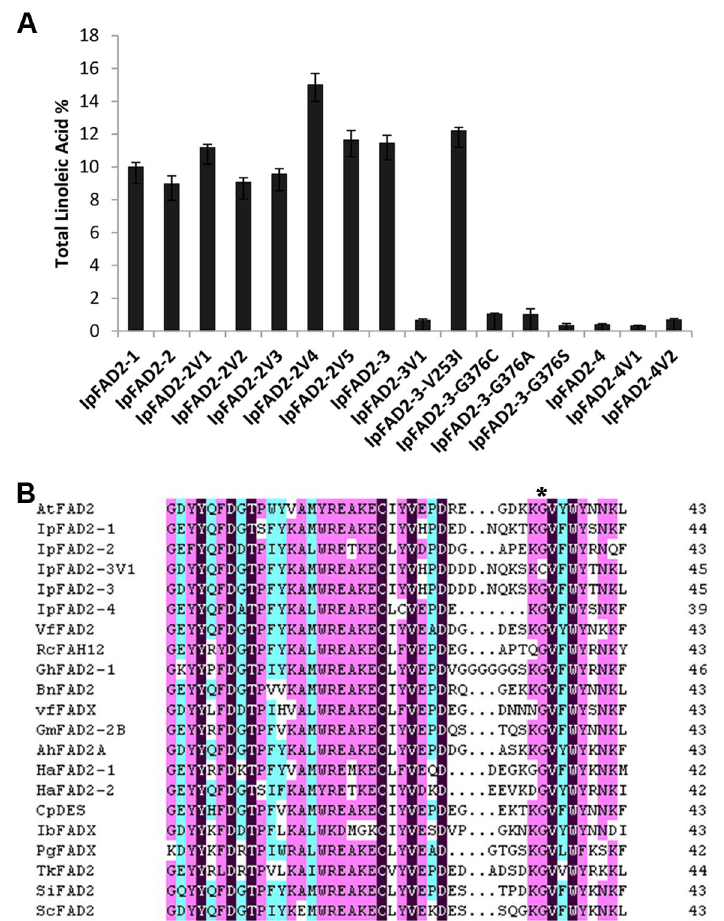
Figure 5. Total C18:2 accumulation in yeast transformed with different FAD2 alleles from Idesia polycarpa . ( A ) Total LA accumulation in transgenic yeast expressing natural FAD2 alleles and site-directed mutations from Idesia polycarpa . ( B ) Alignment of C-terminal amino acids of 21 FAD2 genes. The GenBank accession numbers of the proteins presented in this figure are shown in Figure 2. The asterisk indicates the conserved Glycine residue changed in IpFA2-3V1. The shading colors represent the identity level of amino acids. Black, magenta, and cyan indicate 100%, ~90%, and ~55% identity, respectively.